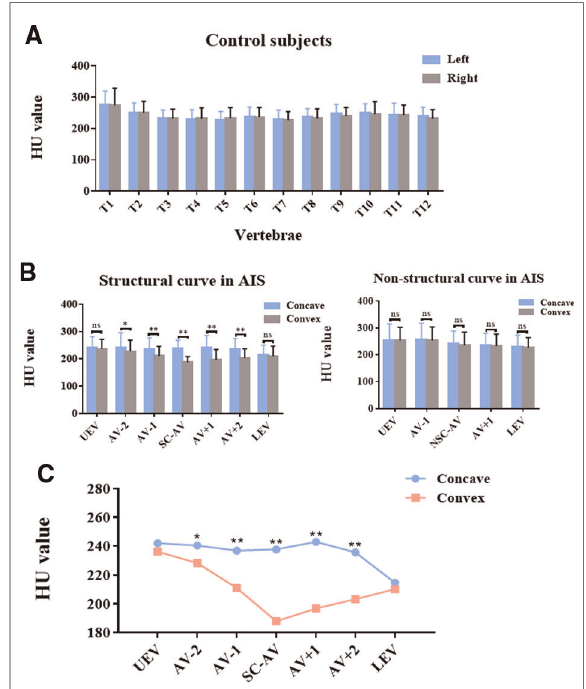
FIGURE 4 Asymmetrical changes in vertebral-body bone quality in AIS patients. ( A ) HU value on the left and right sides of thoracic vertebral bodies in controls. ( B ) HU value on the concave and convex sides of thoracic vertebral bodies in different regions of the structural and non- structural curves in AIS patients. ( C ) Comparison of HU values within the concave and convex sides of thoracic vertebral bodies in different regions of the structural curve in AIS patients. Total 30 patients with Lenke type 1A AIS and 30 paired controls were included in this study. ns: no statistical signi fi cance; * P <0.05 vs. convex group, ** P <0.01 vs. convex group.